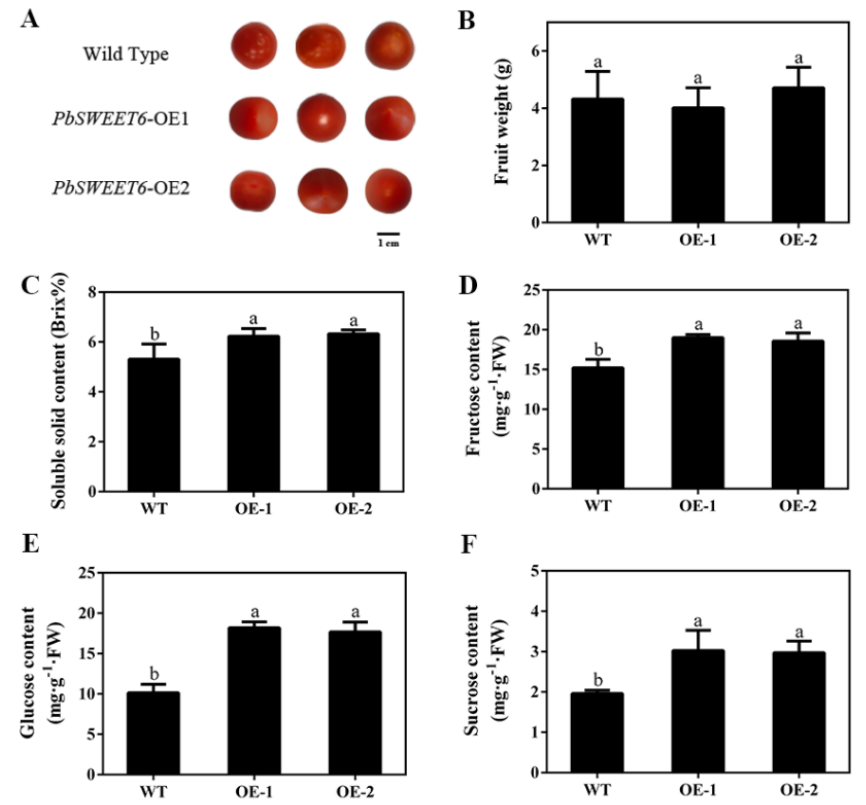
Figure 5. Fruit quality determination in wild type and PbSWEET6 -OE tomato. ( A ) Fruits of wild type and PbSWEET6 -OE lines at the red mature fruit stage; the scale bars correspond to 1 cm. ( B ) Single fruit weight. ( C – F ) The SSC and soluble sugar (fructose, glucose, and sucrose) contents in red mature fruits of the WT and PbSWEET6 -OE lines. The data represent the mean values ± SDs. Different letters represent significant differences (Tukey’s HSD, p < 0.05).